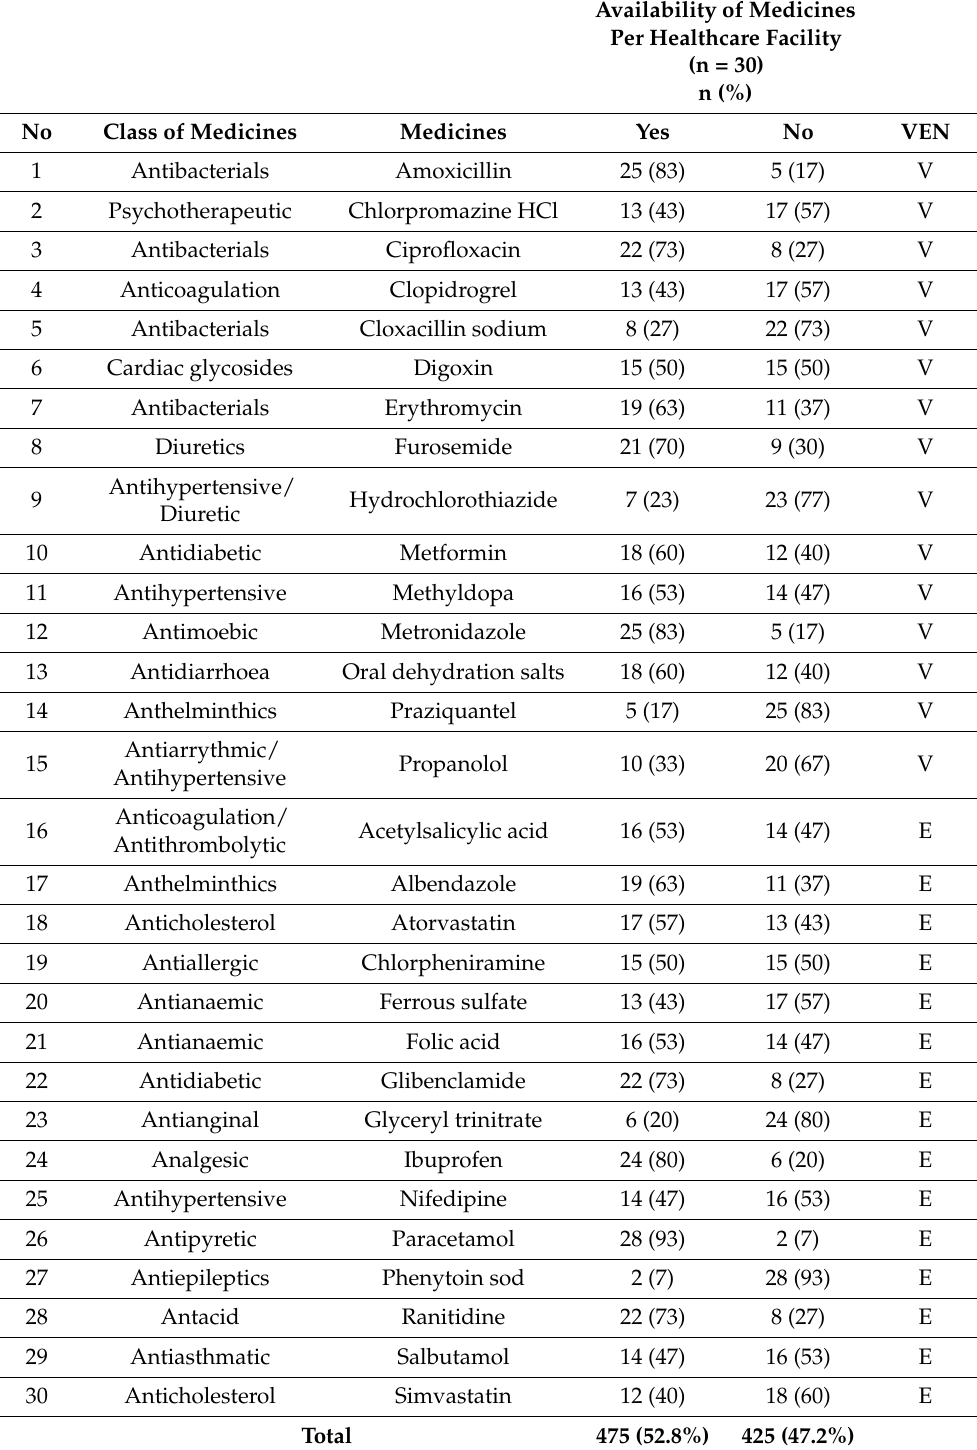
Table 3. Availability of the essential medicines surveyed in this